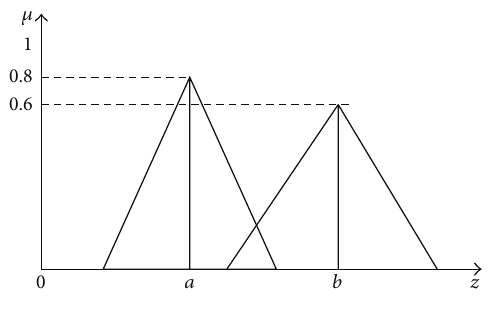
Figure 5: Weighted average